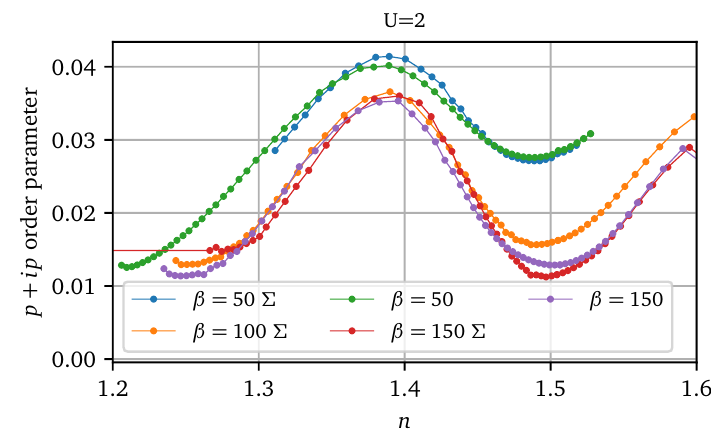
Figure 3: p + ip order parameter found by CDMFT, as a function of electron density n , for U = 2 meV and several variants of the CDMFT procedure explained in the text. Only the electron-doped results ( n > 1) are shown for clarity.